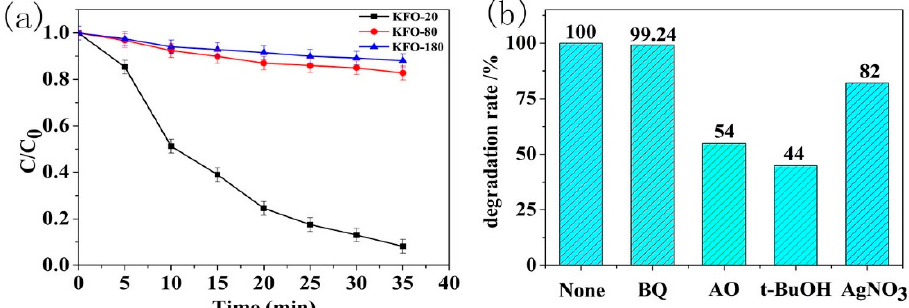
Figure 6. ( a ) Degradation efficiency of crystal violet (CV) with KFO catalysts at pH 2; ( b ) effects of different scavengers on MB degradation at pH 2 in presence of KFO-20, H 2 O 2 , and light.